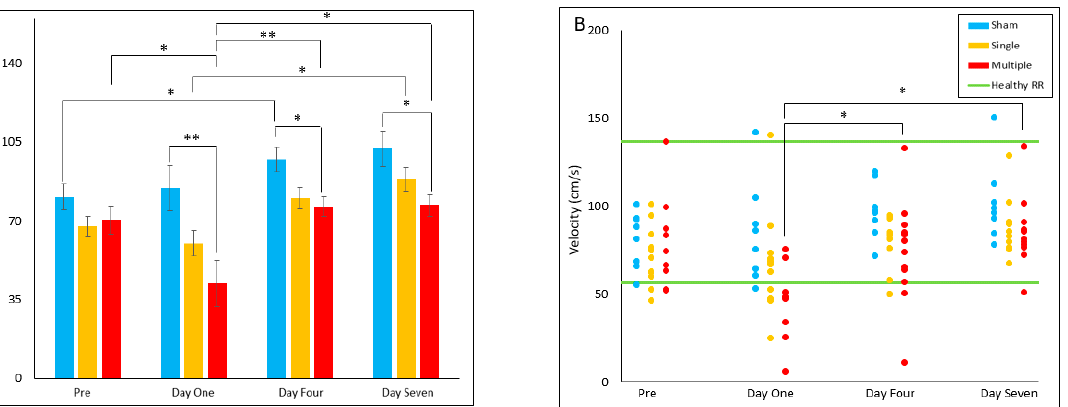
Figure 2. Gait Time ( A ) Presents daily group average ± standard error and statistical comparisons noted from the two-way ANOVA with repeated measures analysis; ( B ) Presents individual ani- mal daily averages with statistical comparisons noted from the Fisher Exact Test and McNemar’s analysis (* p < 0.05).